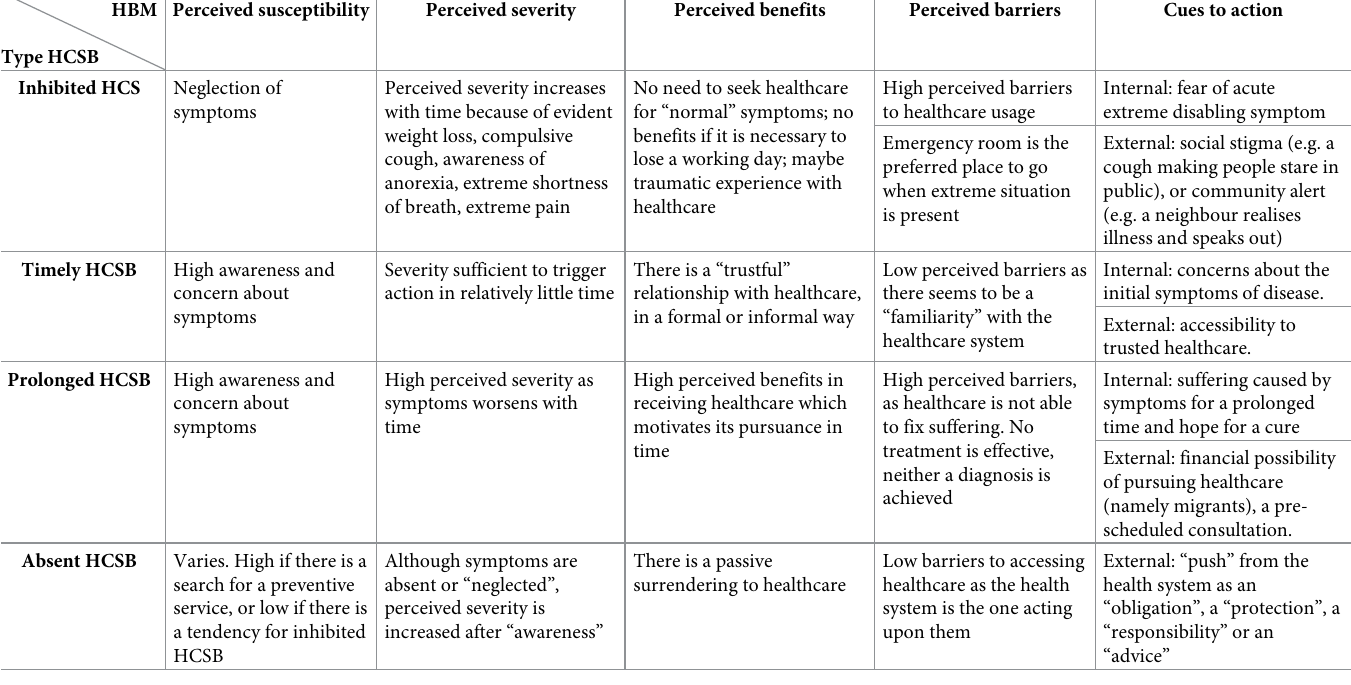
Table 3. Interactions between the Health Belief Model and four types of health seeking behaviour � . The individual perception of illness is influenced by participants´ contexts, and past and present health system´s